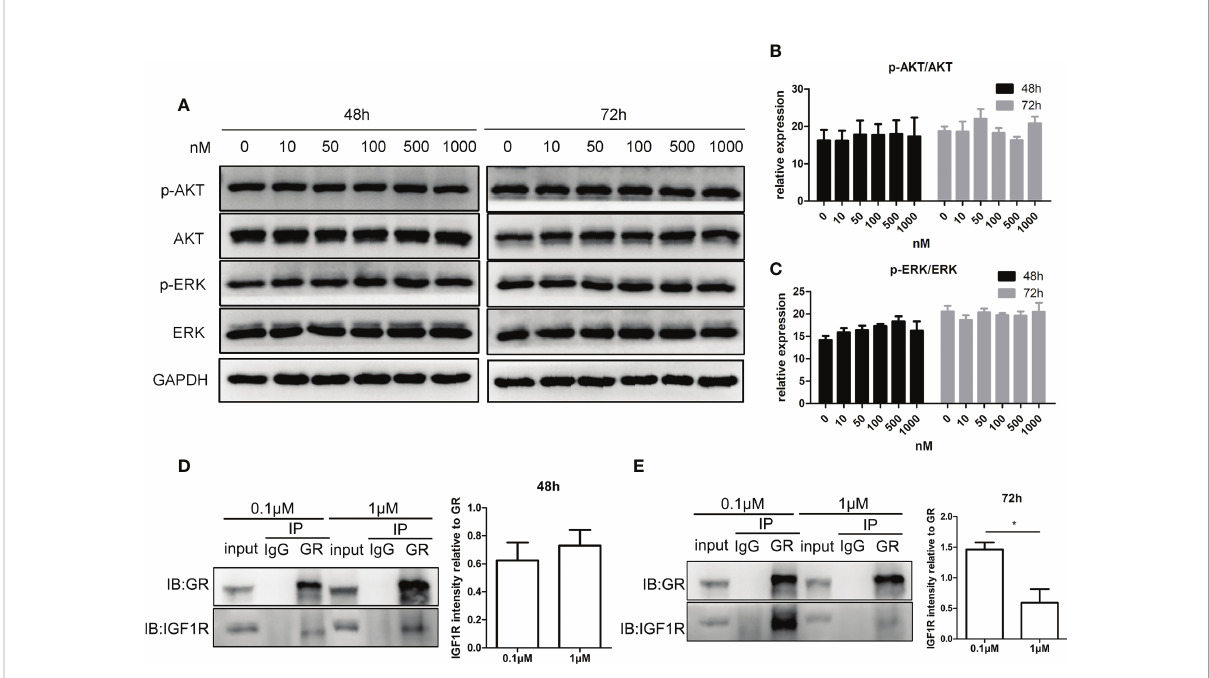
FIGURE 5 Impact of glucocorticoids on cell signals of steroidogenesis and the protein interaction between GR and IGF1R in KGN cells. KGN cells were treated by different doses of CORT for 48 and 72 h, respectively, and harvested for Western blot analysis of AKT, p-AKT, ERK, and p-ERK. (A) Phosphorylation levels of AKT (B) and ERK (C) were determined to assess the direct in fl uence of glucocorticoids on the steroidogenesis signal. n = 3 in each time point and each group; one-way ANOVA. KGN cells were treated with low-dose (0.1 µM) and high-dose (1 µM) CORT, respectively. Protein – protein interaction between GR and IGF1R was detected by Co-IP after 48 h (D) and 72 h (E) . n = 3, t-test. *P <